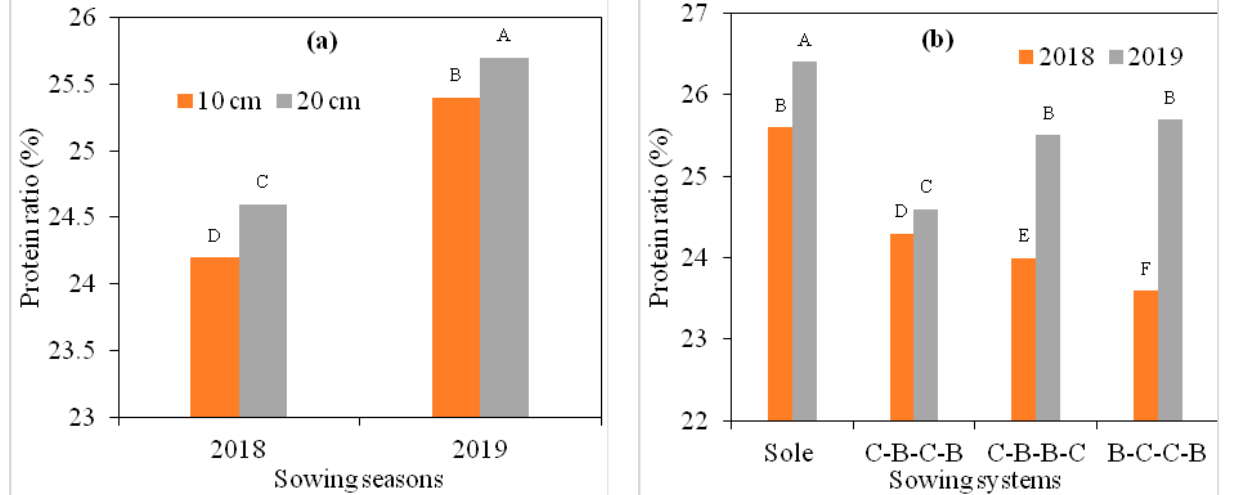
Figure 9. The interactions of maize–white bean sowing systems on protein ratio ( a , b ) at Nur Sultan, Kazakhstan research station. Letters on each bar represent significance level at p < 0.05 and p < 0.01. Note: different letters denote significant differences, while the same letters indicate insignificantly different values.